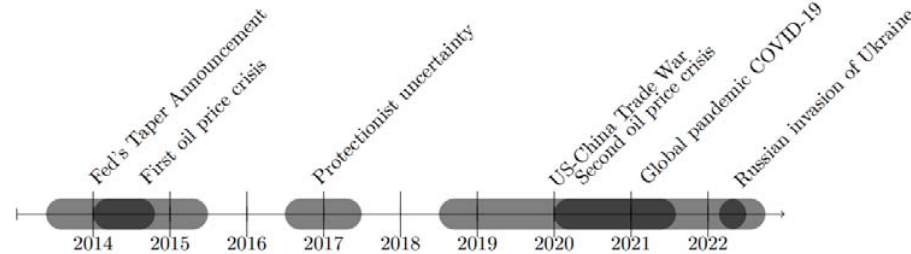
Figure 1. Timeline of principal common financial shocks, 2014–2022. Source: Author’s own research.